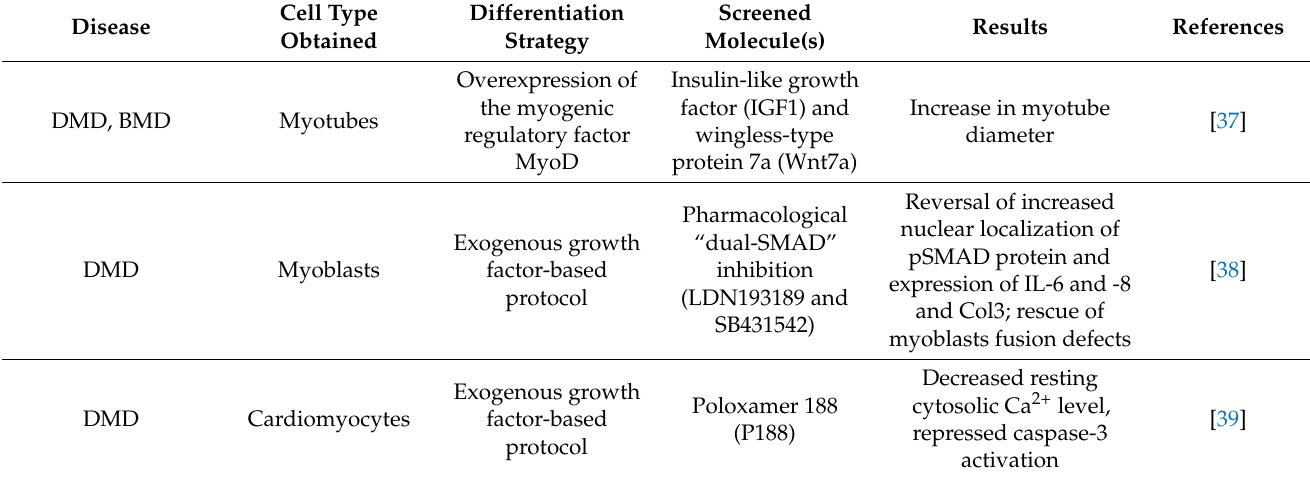
Table 1. iPSC-based models of muscular dystrophies for drug